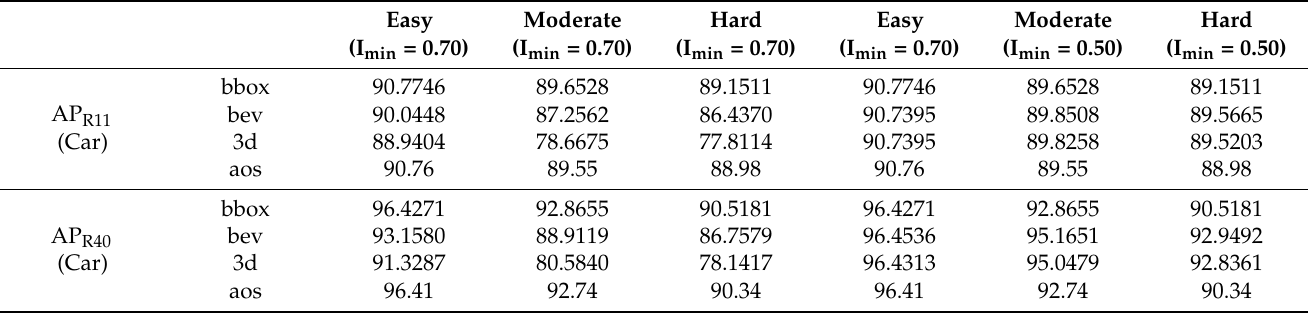
Table 2. The Performance of PointRCNN in the car class of KITTI with different IoU.